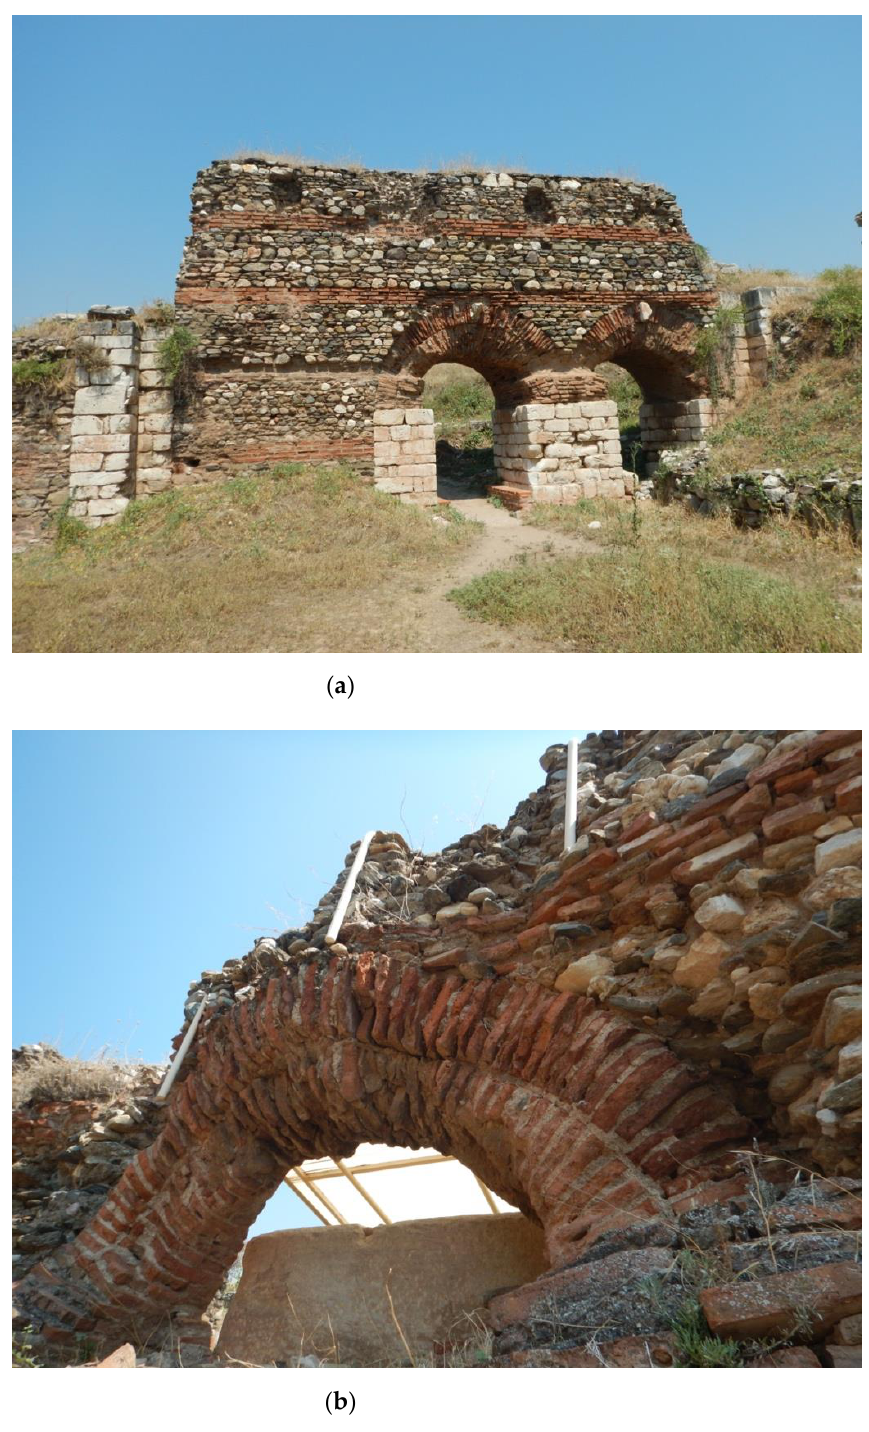
Figure 4. A dilapidated brick vault on lime mortar in the ancient city of Sardis (Turkey IV-V cen- turies): ( a ) Fragment of the fortress wall; ( b ) Brick arch. ( a ) Fragment of the fortress wall; ( b ) Brick